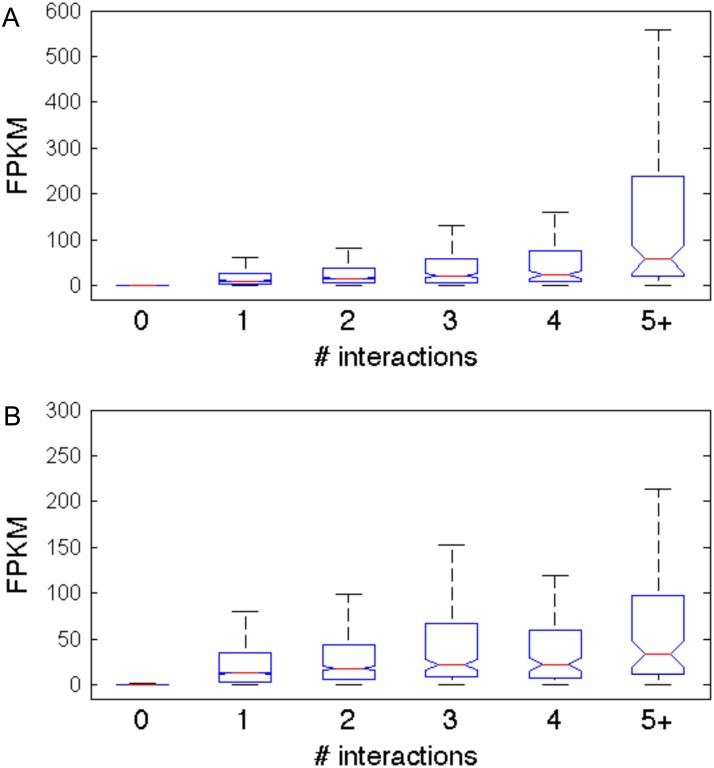
Transcription levels are correlated with the number of nonTSS locations with which a TSS interacts.Genes are categorized based on the number of nonTSS locations that their TSSs interact with in (A) ESCs and (B) pMNs. The boxplots reflect the distribution of FPKM values computed for the genes in each group from RNA-Seq data.